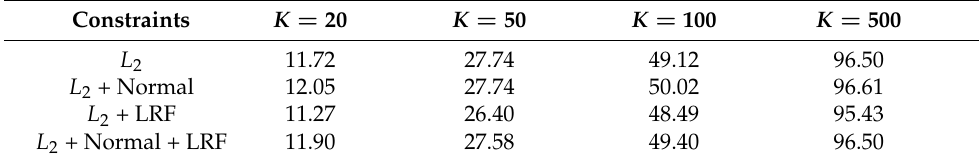
Table 2. The ROI performance (%) of PCV when using different geometric constraints.